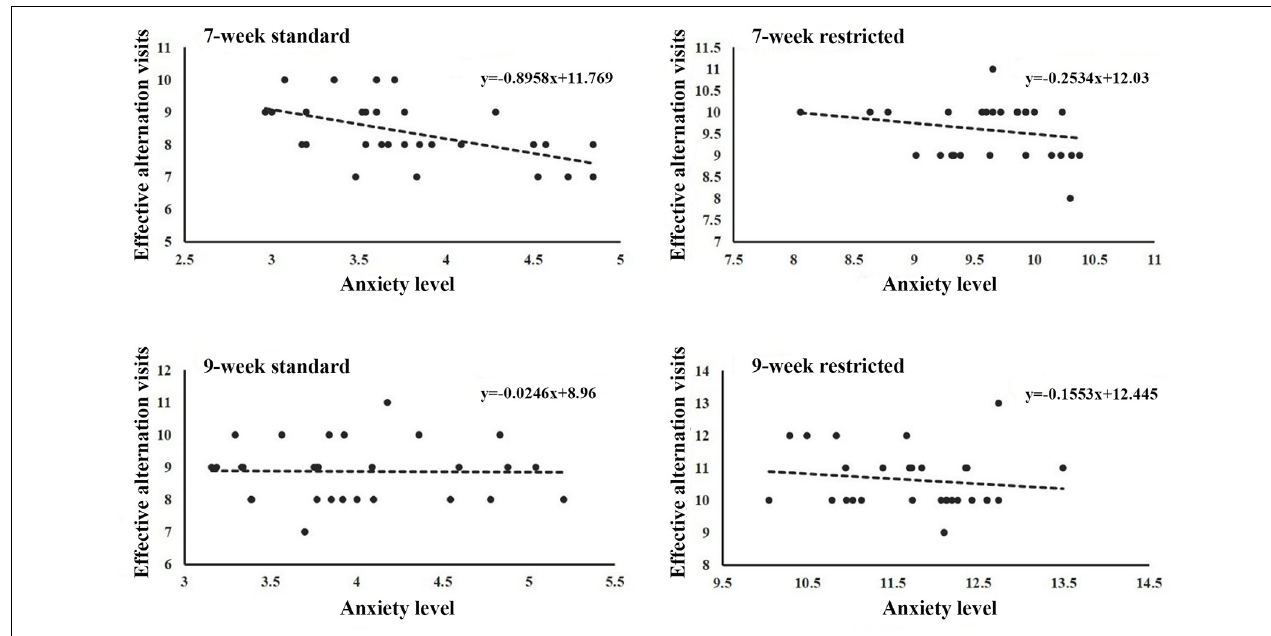
FIGURE 4 | The relationship between anxiety and working memory. A significant correlation of anxiety level with working memory was only found in the 7-week-old standard-cage mice ( P < 0.01), but not other